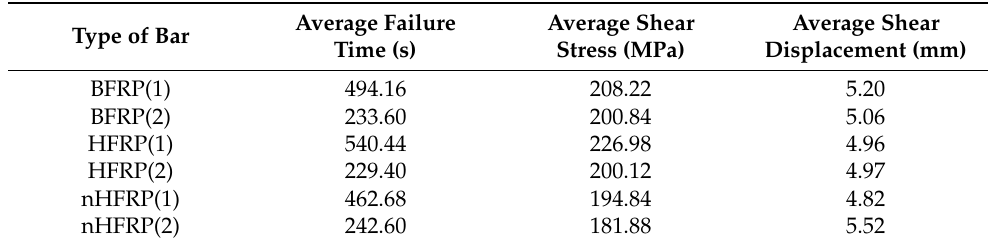
Figure 7. Surface changes observed after the shear test. Sample Ø8 previously heated to 200 °C for 2 h: yellow/orange color visible at the shear point ( a ), delamination of the Ø10 bar structure ( b ).